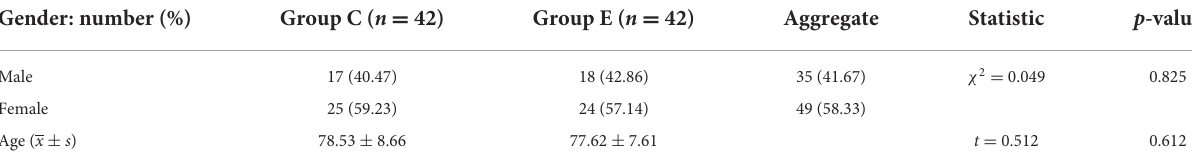
TABLE 1 Comparison of general conditions of the two